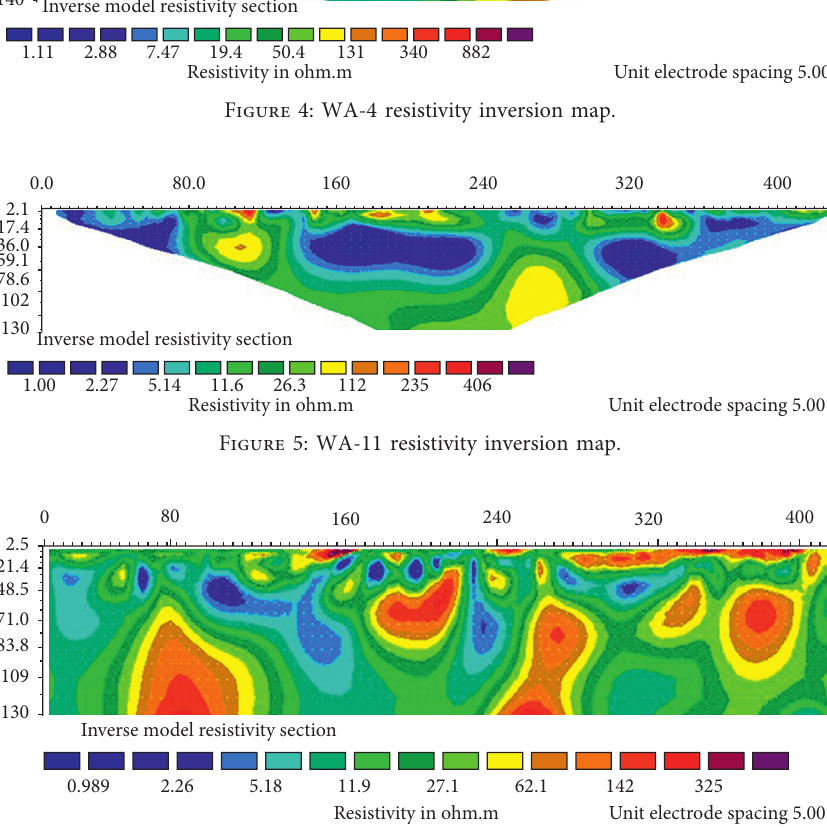
Figure 6: WA-33 resistivity inversion